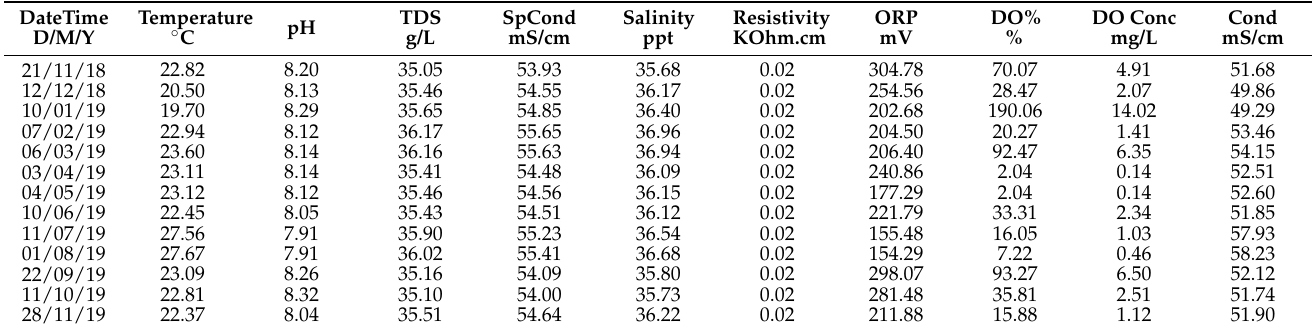
Table 2. Values of the chemical–physical parameters of water in the laboratory